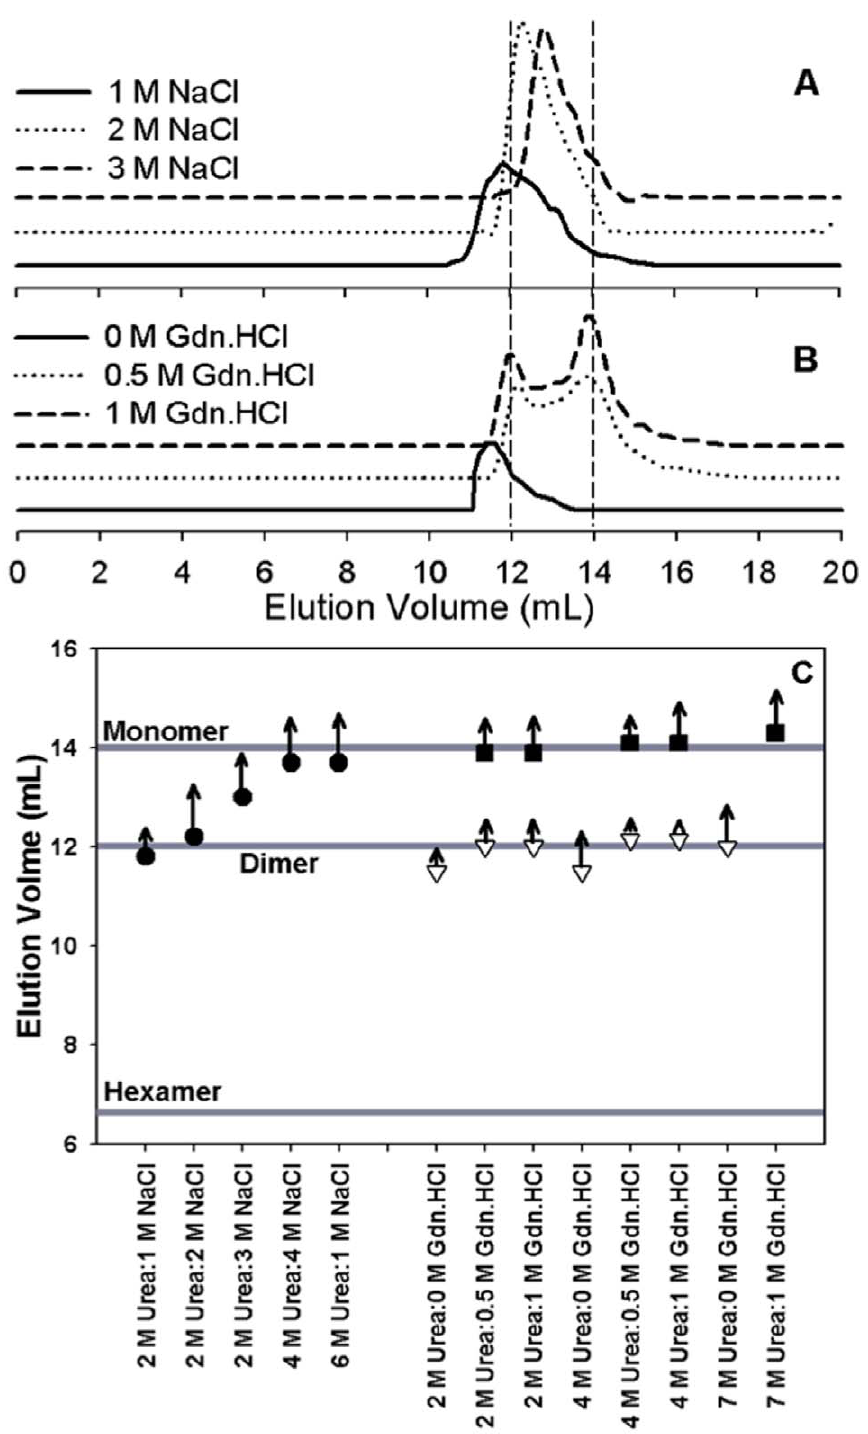
Figure 4. SEC studies of insulin. Panel A shows representative SEC profiles (absorbance 280 nm) of insulin obtained in the presence of varying concentrations of NaCl and urea at pH 7.4, (solid line) 2 M urea:1 M NaCl, (dotted line) 2 M urea:2 M NaCl, (dashed line) 2 M urea:3 M NaCl. Panel B shows representative SEC profiles obtained in the presence of varying concentrations of Gdn.HCl and Urea at pH 7.4, (solid line) 2 M urea:0 M Gdn.HCl, (dotted line) 2 M urea:0.5 M Gdn.HCl, (dashed line) 2 M urea:1 M Gdn.HCl. Vertical dotted lines on Panel A and B corresponding to elution volumes at max peak heights. Panel C provides overall SEC analysis. The three solid lines act as markers for the monomeric, dimeric and hexameric insulin based on SEC elution volumes (mL). Symbols show the elution volume of the associated species of insulin (mono- or multi-meric state) and the arrows on the symbols show the intensity (scaled down in millimeters) of the corresponding peaks in the range of this study. Filled circles represent elution volumes (mL) at different urea and NaCl concentrations as shown along the ordinate axis corresponding to each data point. Filled squares and inverted triangles represent the elution volumes (mL) of insulin treated with different concentrations of urea and Gdn.HCl shown accordingly on the ordinate axis.